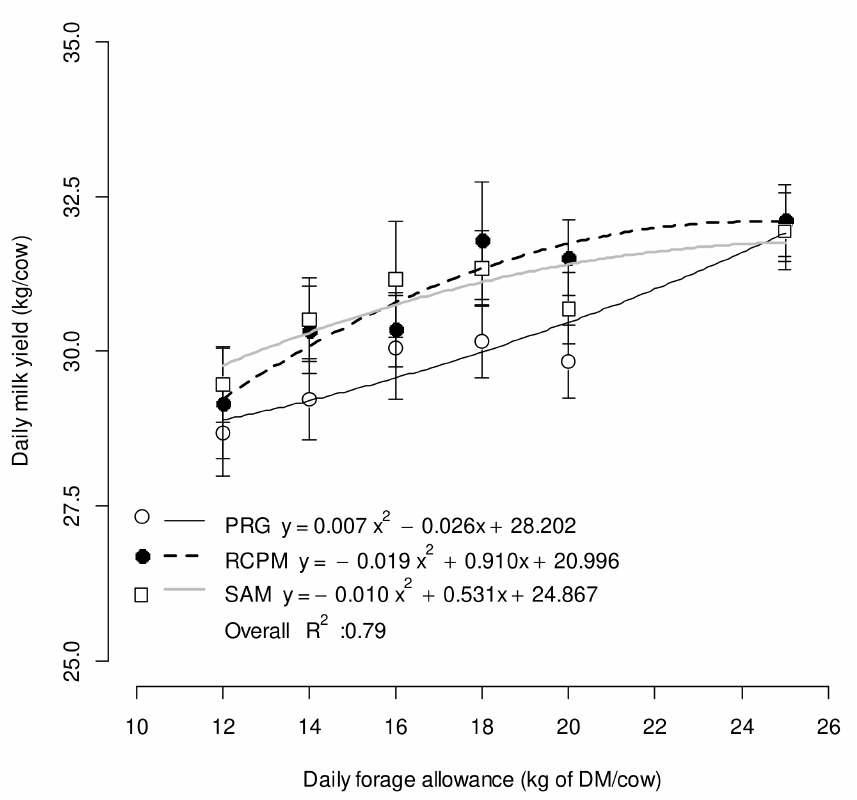
Figure 2. Milk yield (kg/cow per day) response of early lactation dairy cows to increasing allowances (kg of DM/cow per day) of different forage types, including PRG, perennial ryegrass monoculture (solid black line); RCPM, perennial ryegrass, white clover and plantain mixture (broken black line); and SAM, spatially adjacent monocultures of perennial ryegrass, white clover and plantain (grey line). As forage type significantly improved the variance accounted for by the model, separate forage type relationships are shown. Symbols are means ± SEM ( n =